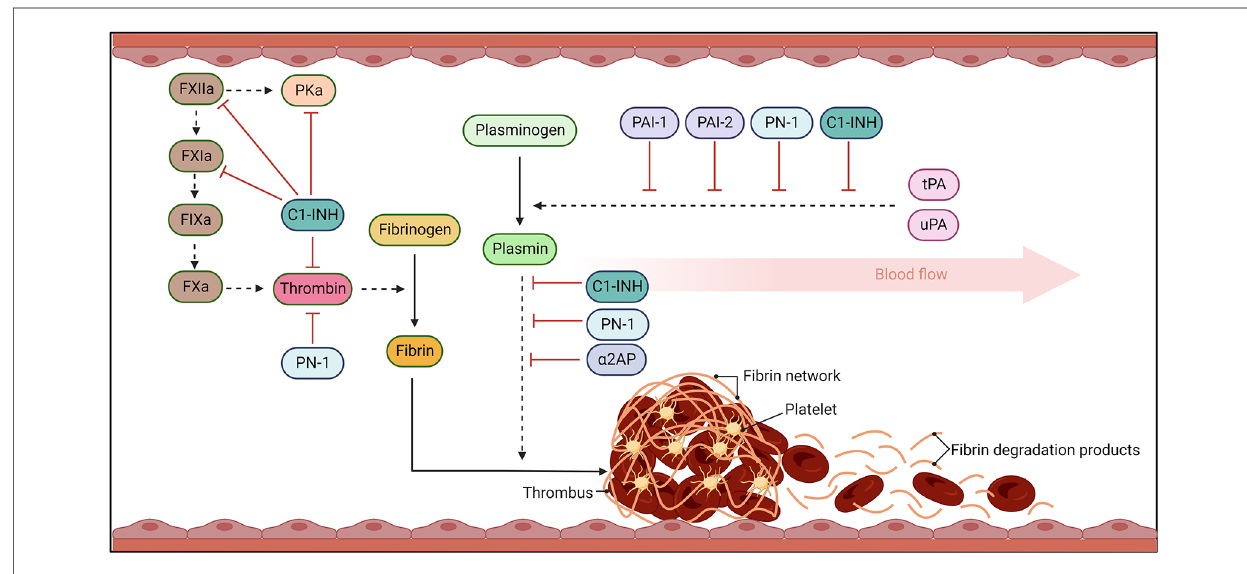
FIGURE 1 The fi brinolytic response. Coagulation results in thrombin cleavage of fi brinogen into fi brin. Fibrin threads become crosslinked, trapping platelets and blood cells, stabilising the clot. Once bleeding has been controlled and damage to vessel repaired, the fi brinolytic pathway acts to dissolve the fi brin network. Fibrinolysis occurs when plasminogen activators, urokinase- (uPA) and tissue-type- (tPA), cleave plasminogen to plasmin. Plasmin then degrades fi brin into fi brin degradation products (FDP) which can be ef fi ciently cleared from the circulation. Serine protease inhibitors (SERPINs) act to inhibit the activity of these serine proteases to avoid uncontrolled activity that can lead to bleeding complications and dysregulated activity. Solid arrows signal catalytic conversion of proteins and enzymes from inactive to active states, while dashed arrows signal proteolytic activity. Blunt red arrows denote the speci fi c inhibition of enzymes by different